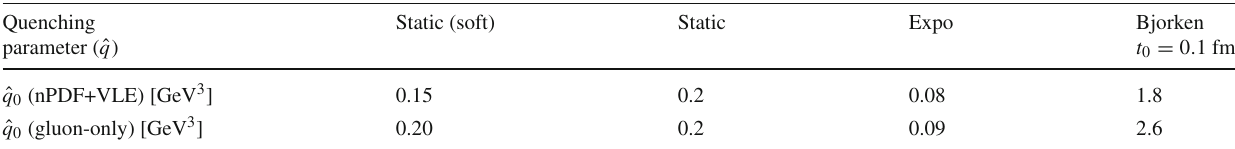
Fig. 2 Left: jet R AA for static medium in four configurations: two version of vacuum input parton spectra (“vacuum 1,2”), spectra with nPDF effects (“nPDF”) and spectra with nPDF effects and vacuum-like emissions included (“nPDF+VLE”). Right: jet R AA for “nPDF+VLE” Table 2 The jet quenching parameter for different media profiles obtained from fitting the calculation to the data from Ref. [44]. Full description of the input parton spectra (first line) can be compared with Quenching Static